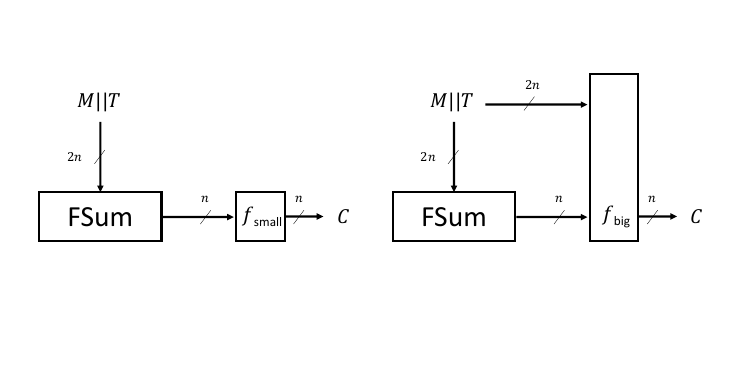
Figure 4: Comparison of FSF small ( M, T ) and FSF big ( M, T